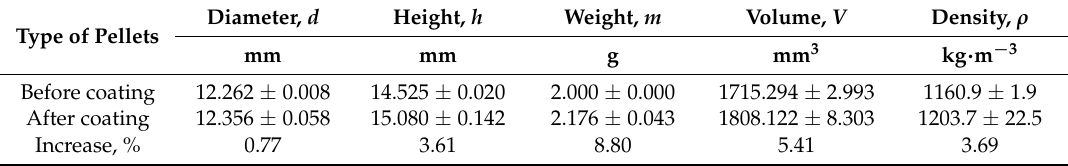
Table 5. Dimensions, weight, and density of carbonized refuse-derived fuel (CRDF) pellets (produced with 50.8 MPa pressure) coated with water glass, mean ± standard deviation, n =